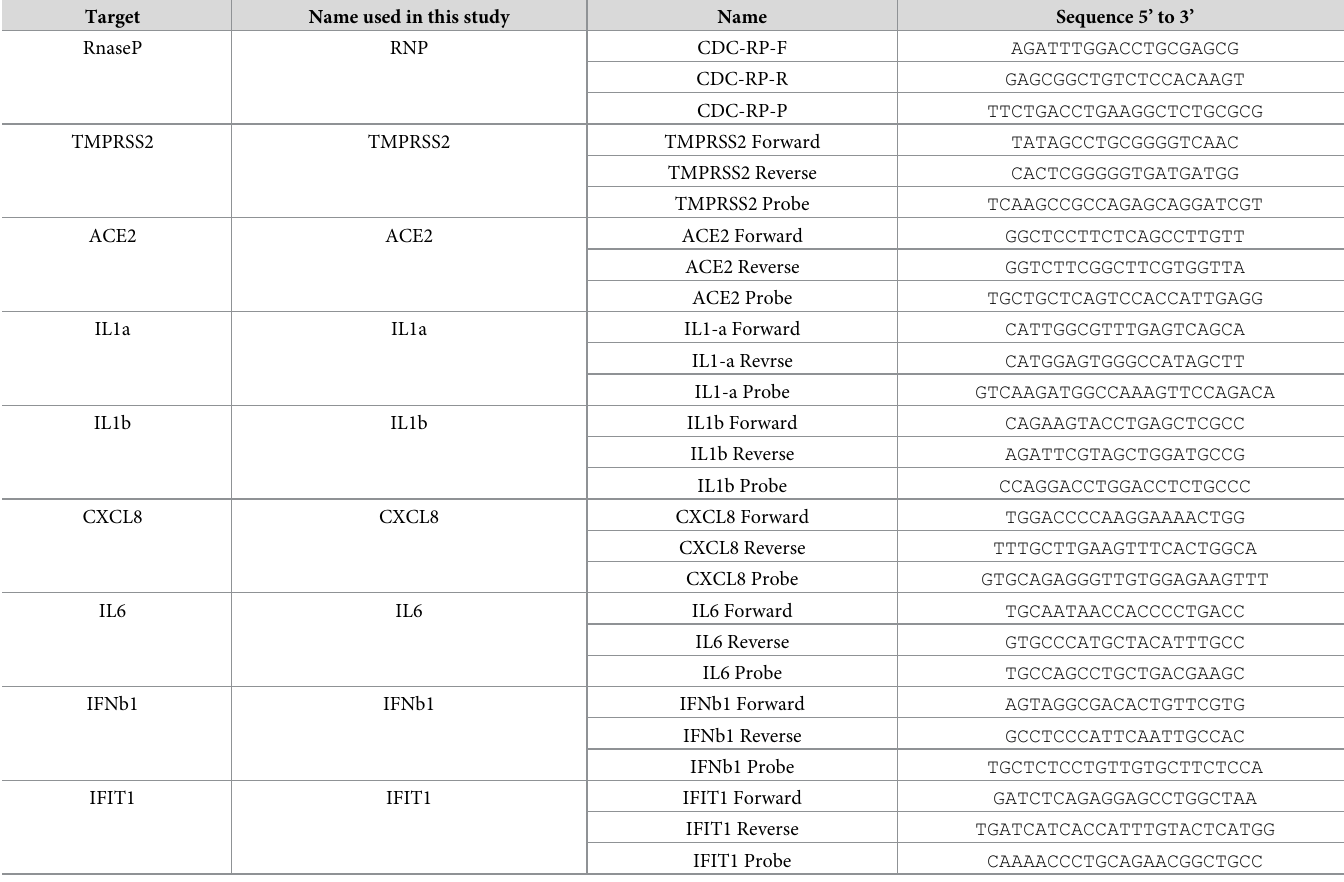
Table 2. List of primers/probe for cellular genes